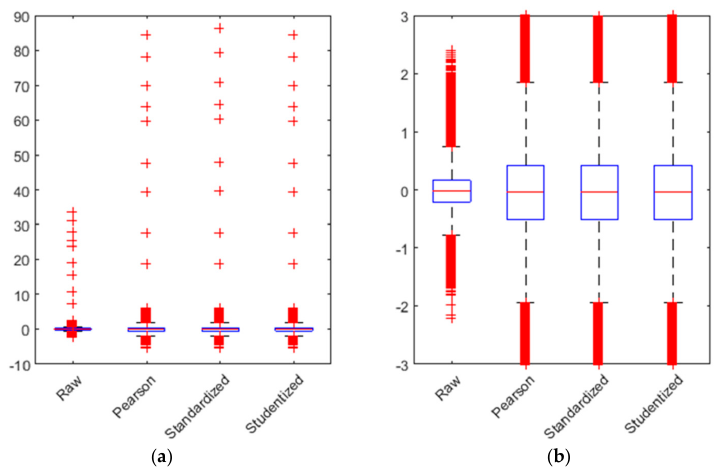
Figure 7. Boxplot of residuals. ( a ) Boxplot of residuals (automatic axis). ( b ) Boxplot of residuals (zoomed in).